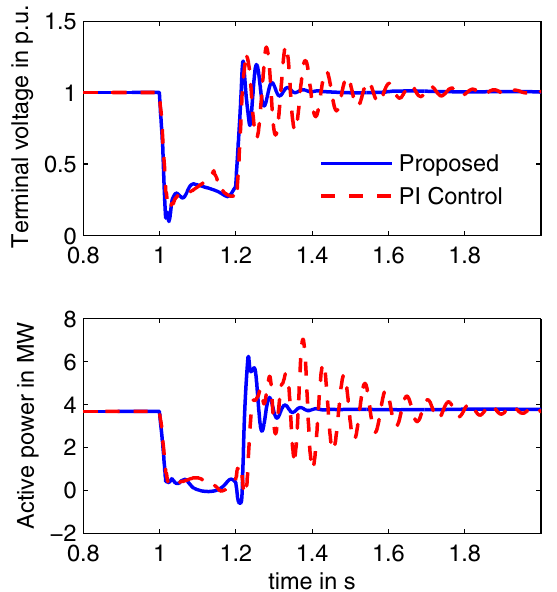
Fig. 11 Response of DFIG for a fault at bus 5